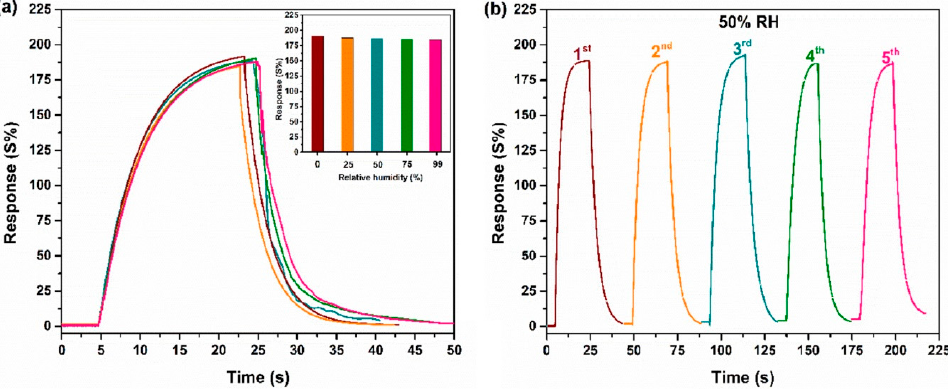
Figure 25. (a) Sensor response of sodium ascorbate-treated Ti 3 C 2 T x /WO 3 nanocomposite at different humidity levels (RH= 0–99%) and ( b ) its signal reproducibility at 50% relative humidity versus 200 ppb NO 2 at RT. Reprinted with permission from [129]. Copyright 2022: American Chemical Society.